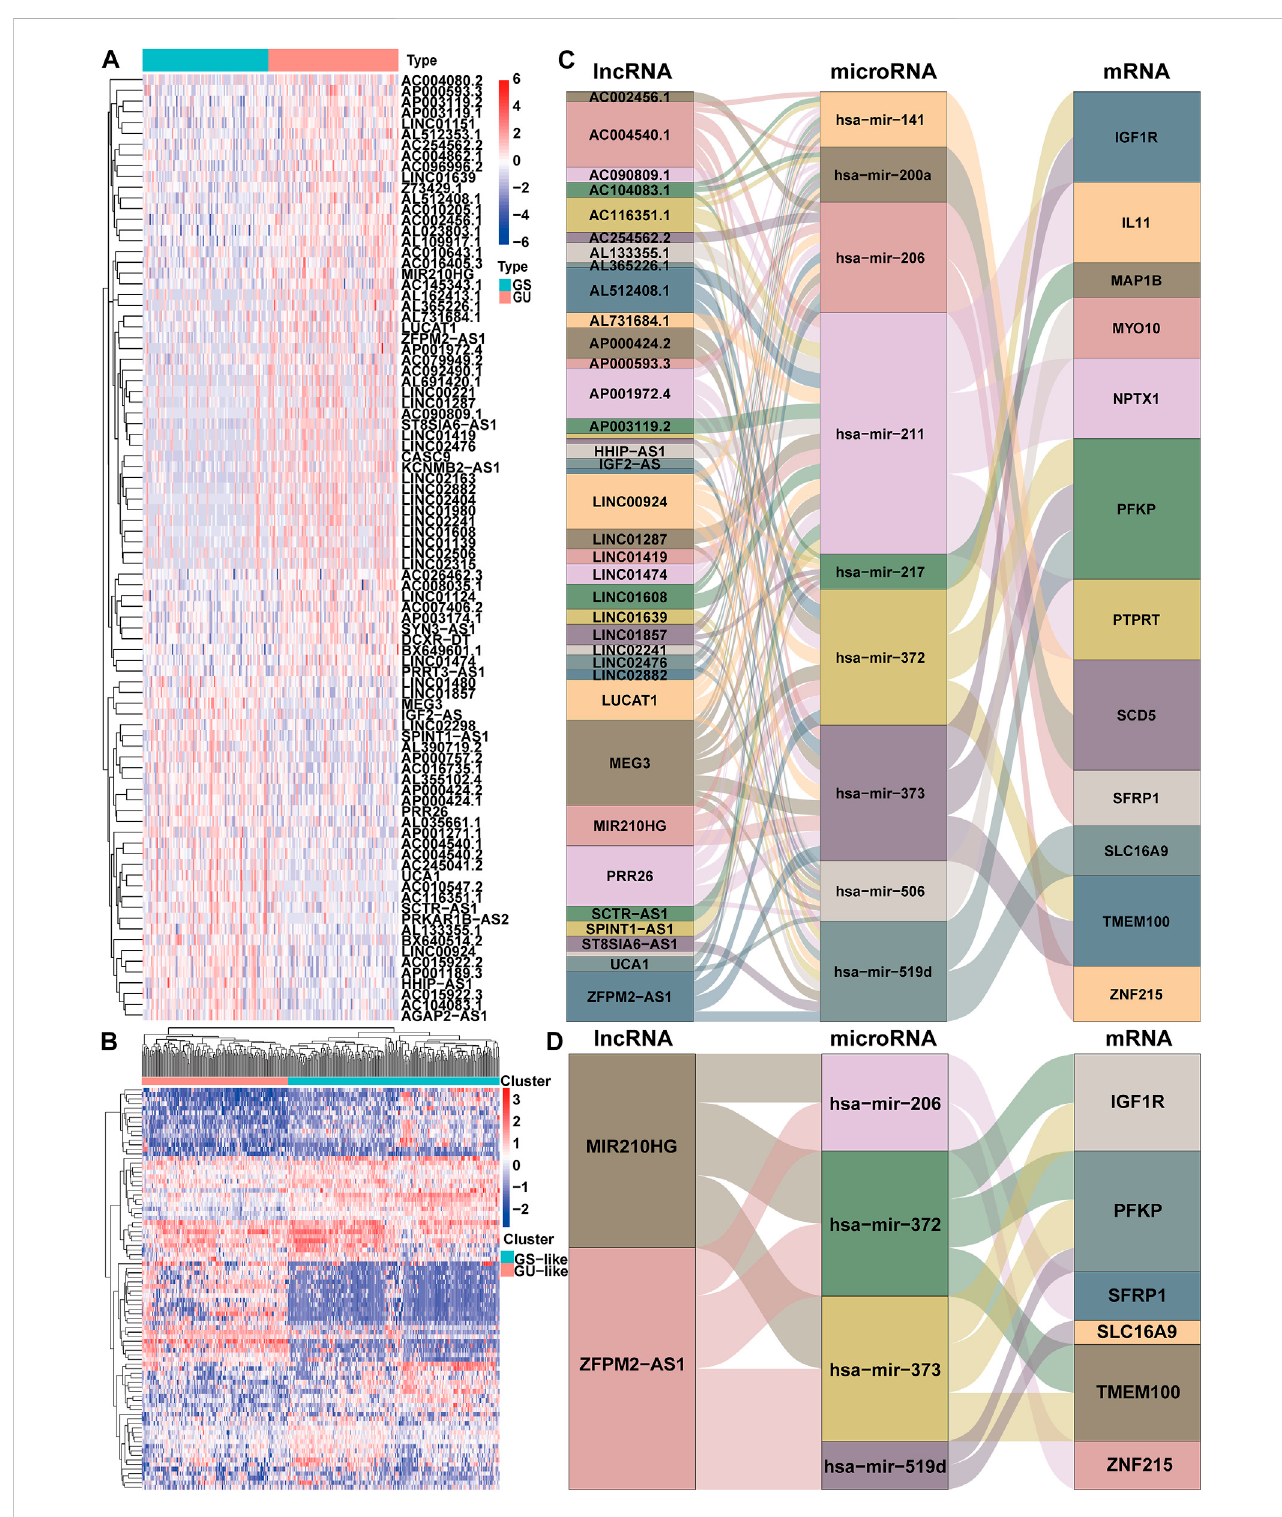
FIGURE 2 Identi fi cation and ceRNA network analysis of genomic instability-associated lncRNAs in HCC. (A) Differential expression of 88 genomic instability- associated lncRNAs between the genomic stable set and genomic unstable set (B) Unsupervised clustering analysis of 364 HCC samples according to the expressionpatternsof88selectedlncRNAscorrelatedwithgenomicinstability.SankeydiagramoftheceRNAnetworkofalllncRNAscorrelatedwithgenomic instability (C) and Sankey diagram of the ceRNA network of ZFPM2-AS1 and MIR210HG (D) . The connection degree of each gene represented by a rectangular box is proportional to the size of the rectangle. GS: genomic stable; GU: genomic